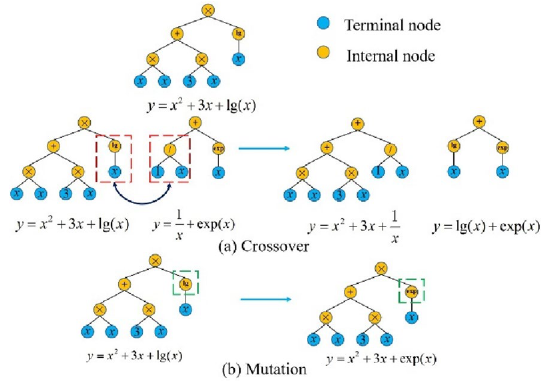
Figure 2 Structure trees of SR